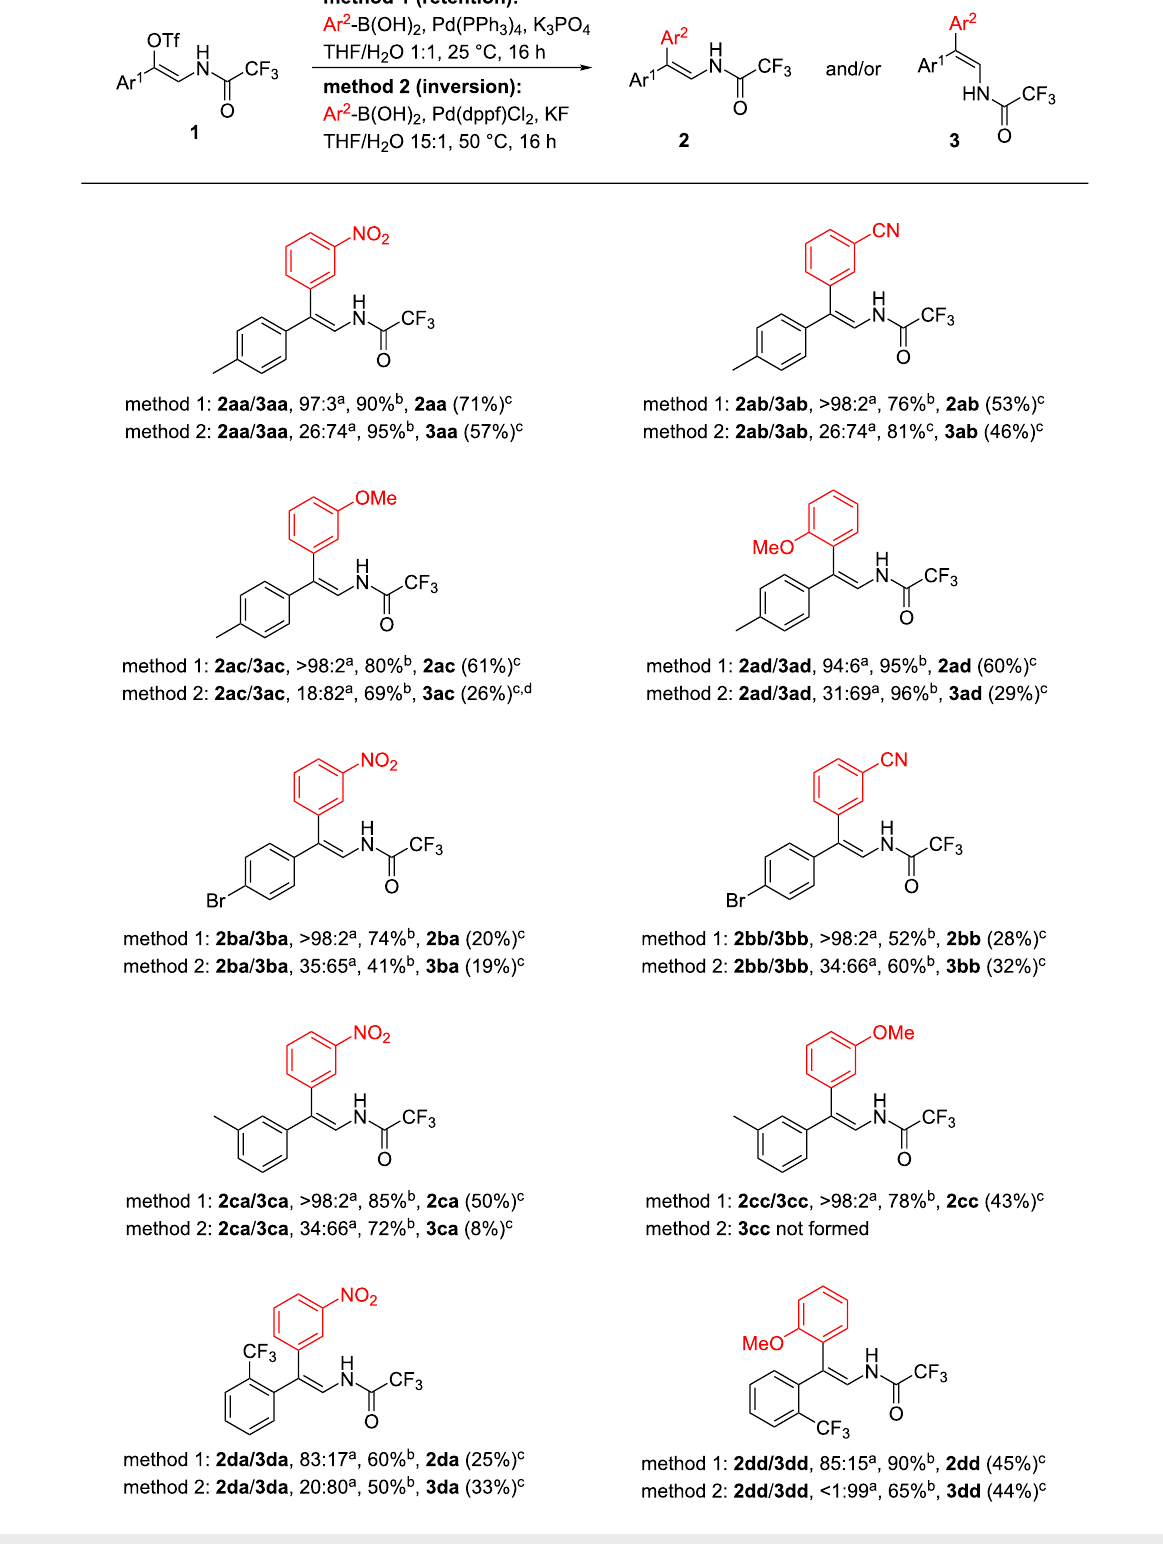
Scheme 2: Substrate scope of the Suzuki coupling leading to enamides 2 and 3 . a Ratio determined by 19 F NMR; b yield determined by 19 F NMR using PhCF 3 as an internal standard; c isolated yield; d isolated as a mixture of isomers E / Z =